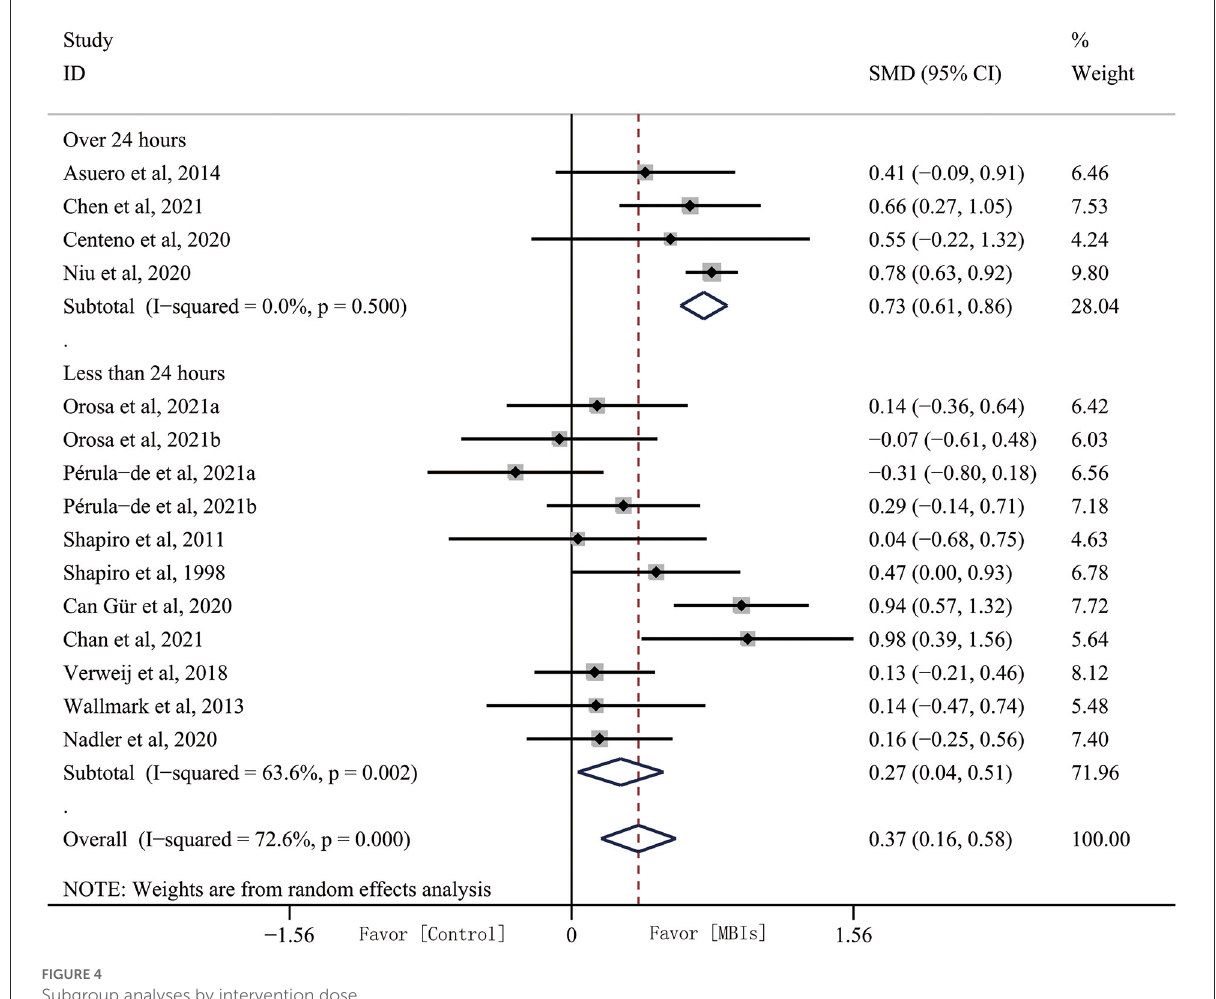
FIGURE4 Subgroup analyses by intervention